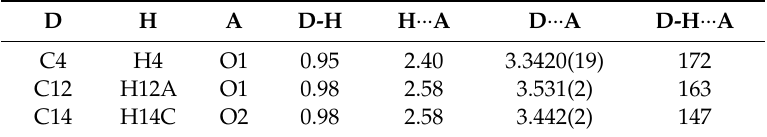
Table 4. The list of selected hydrogen bond Å in compound 3.